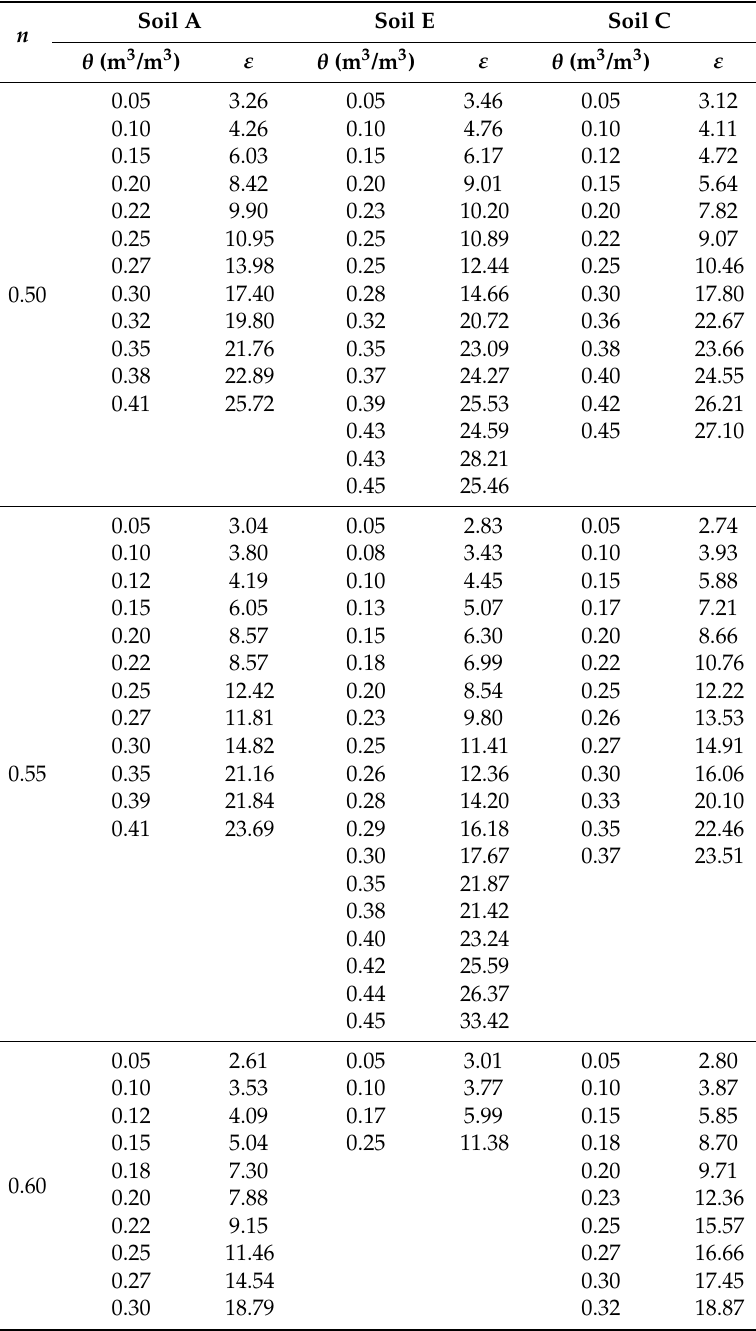
Table 2. Experimental data of soil volumetric water content and dielectric permittivity of the three investigated soils for the different tested